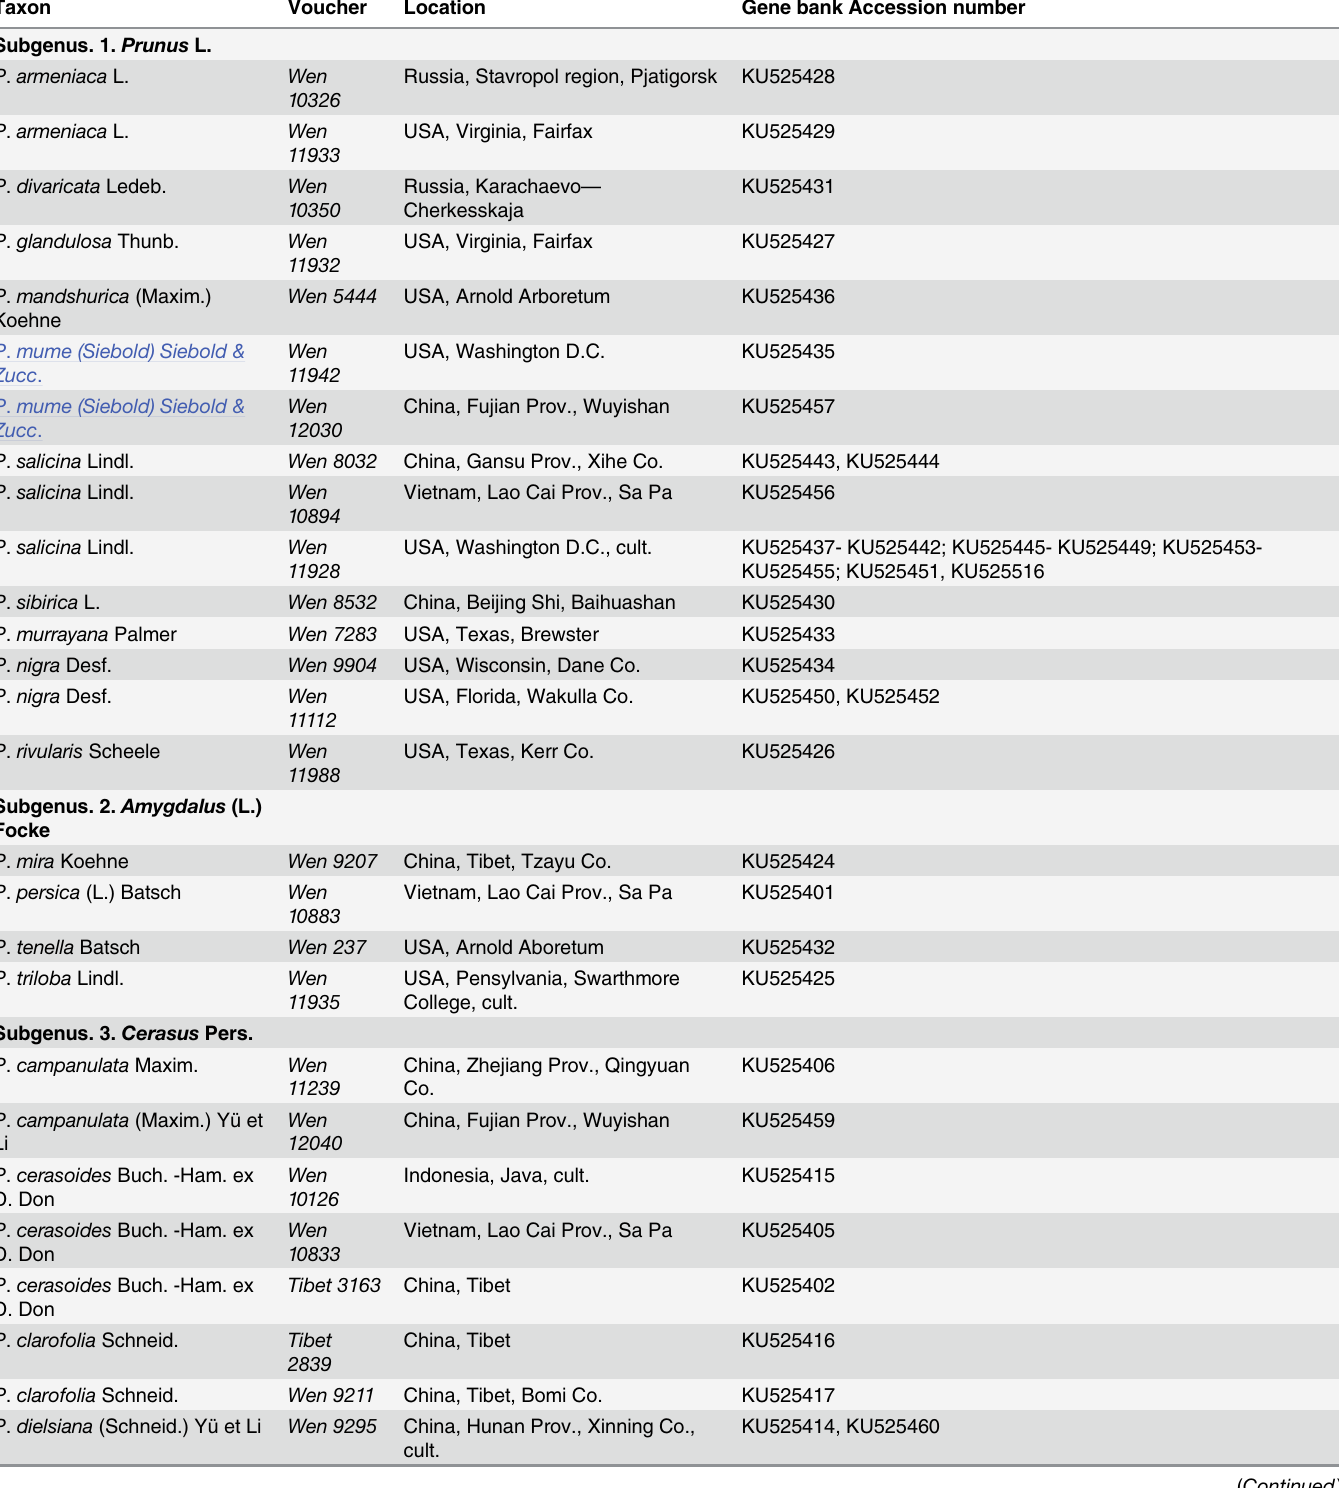
Table 1. Taxa and At103 gene GenBank accession numbers of Prunus and outgroups sampled for this study. All voucher specimens (except one col- lection Potter 081118 deposited in DAV) are deposited in the US National Herbarium (US).